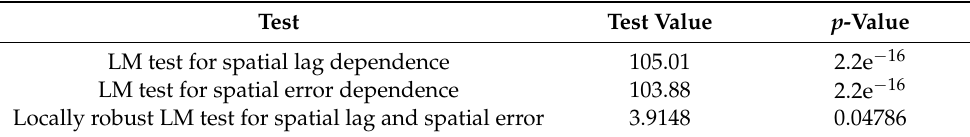
Table 4. Tests for checking the spatial lag dependence. Source: own calculations based on the raw data taken from Ref.